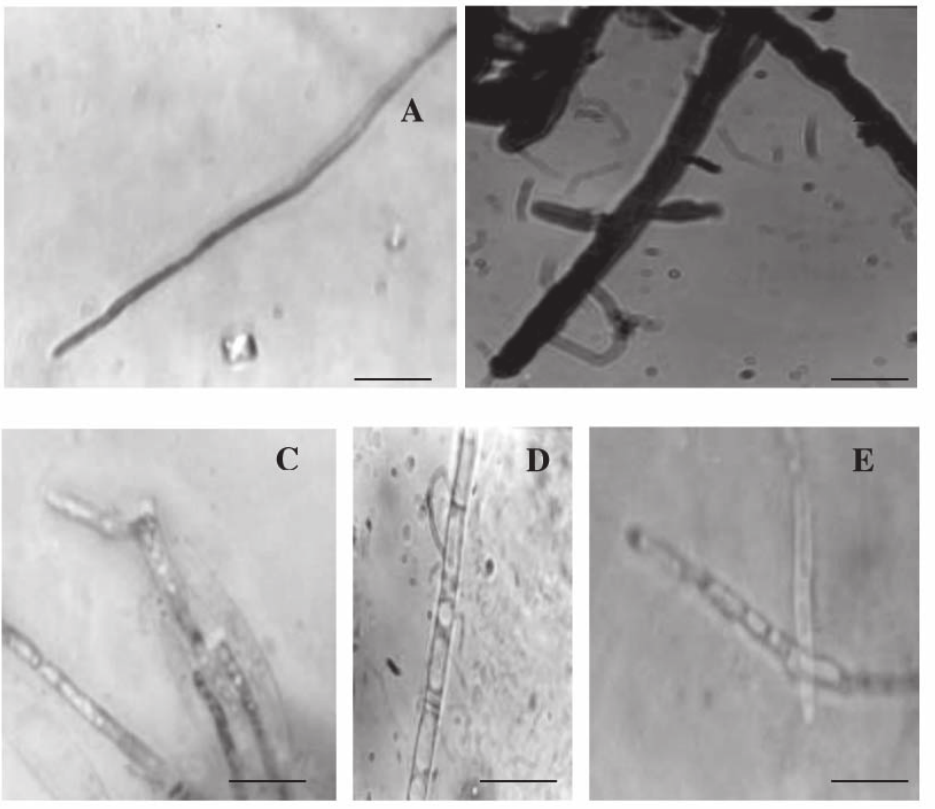
Fig. 5. Microscope photographs of Fusarium oxysporum f. sp. ciceris hyphae cultured on PDA amended with crude phenolic extract (500 µg eq catechin ml -1 ). A and B, control (respectively young and old healthy mycelium); C, pres- ence of vesicles; D, vacuolation; E, emptied mycelium.